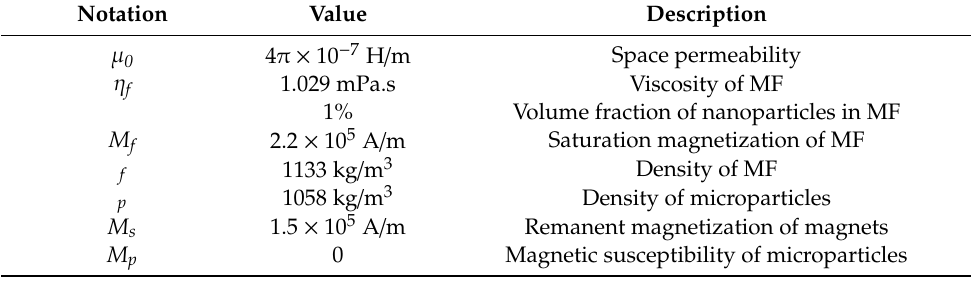
Table 1. Parameters for the numerical simulation.